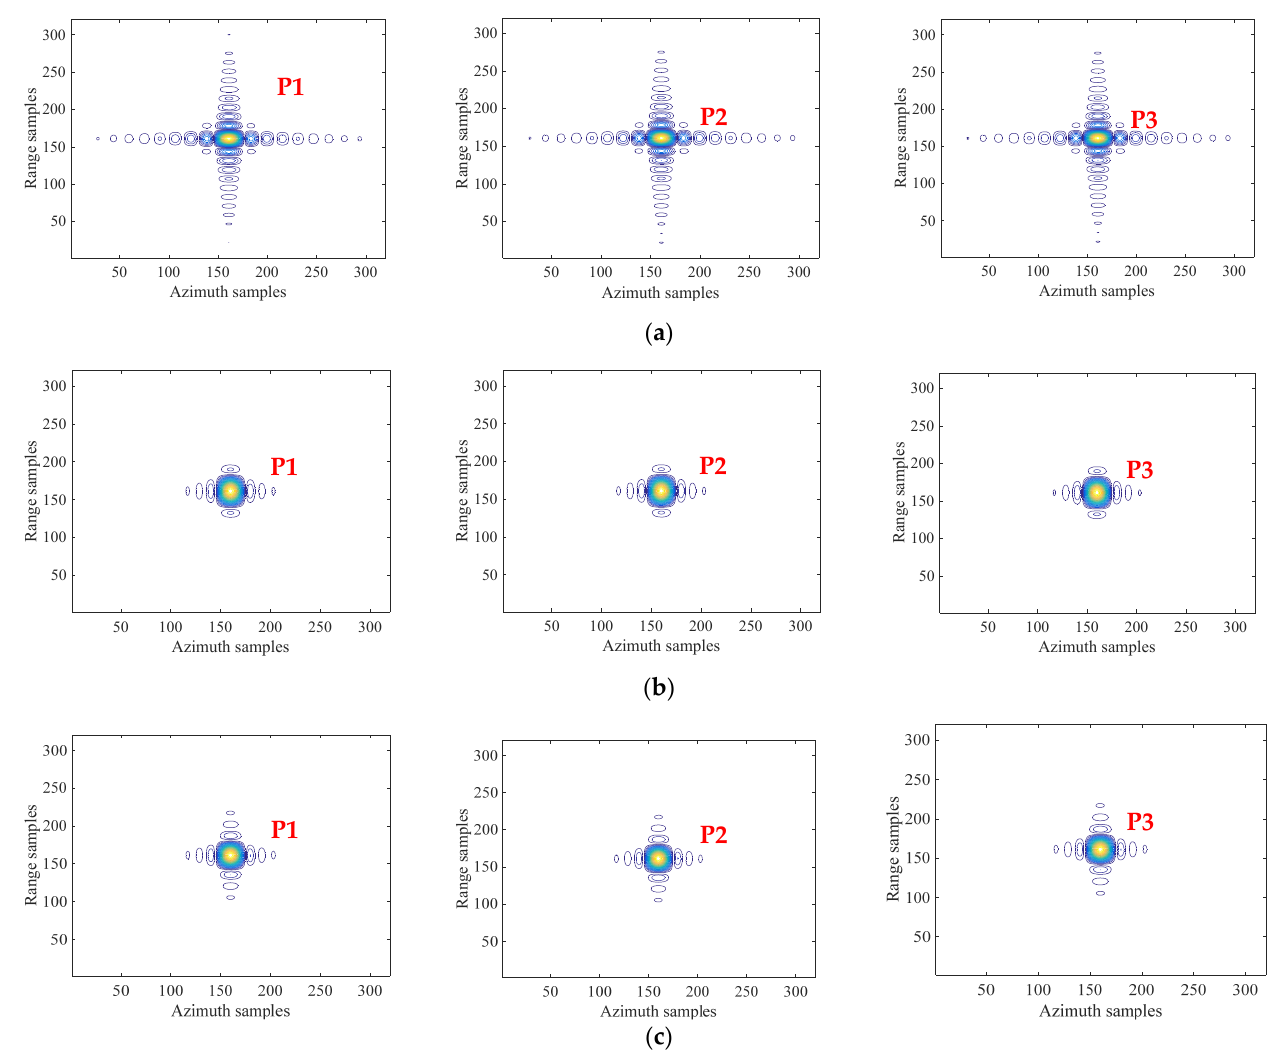
Figure 10. Contour plots of imaged point targets. ( a ) Without windowing in the conventional mode. ( b ) With windowing in the conventional mode. ( c ) Without windowing in the proposed mode. Table 2. Measured focusing parameter of imaging results on the designed scene.